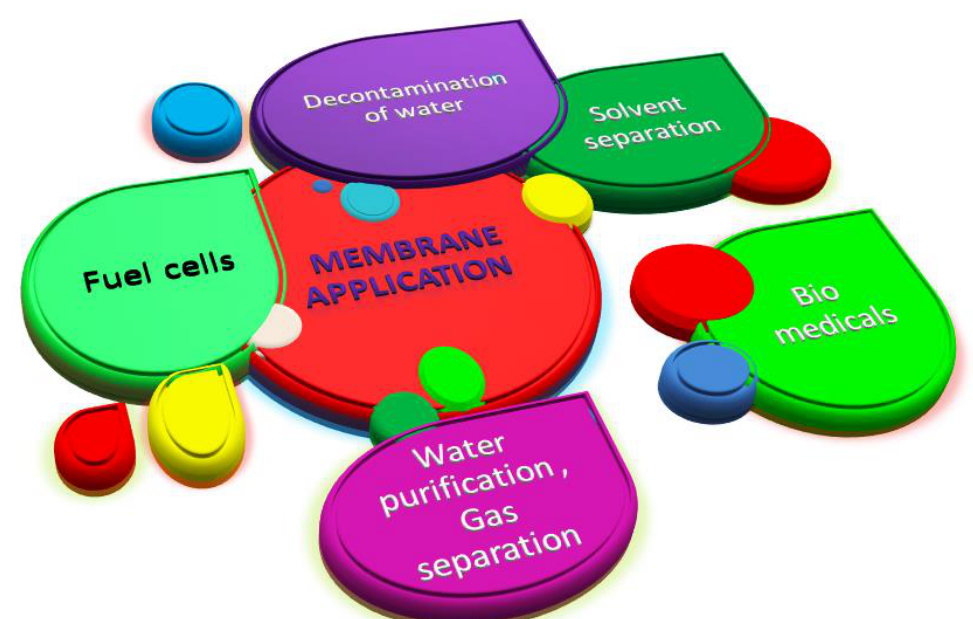
Figure 9. Membranes ’ environmental